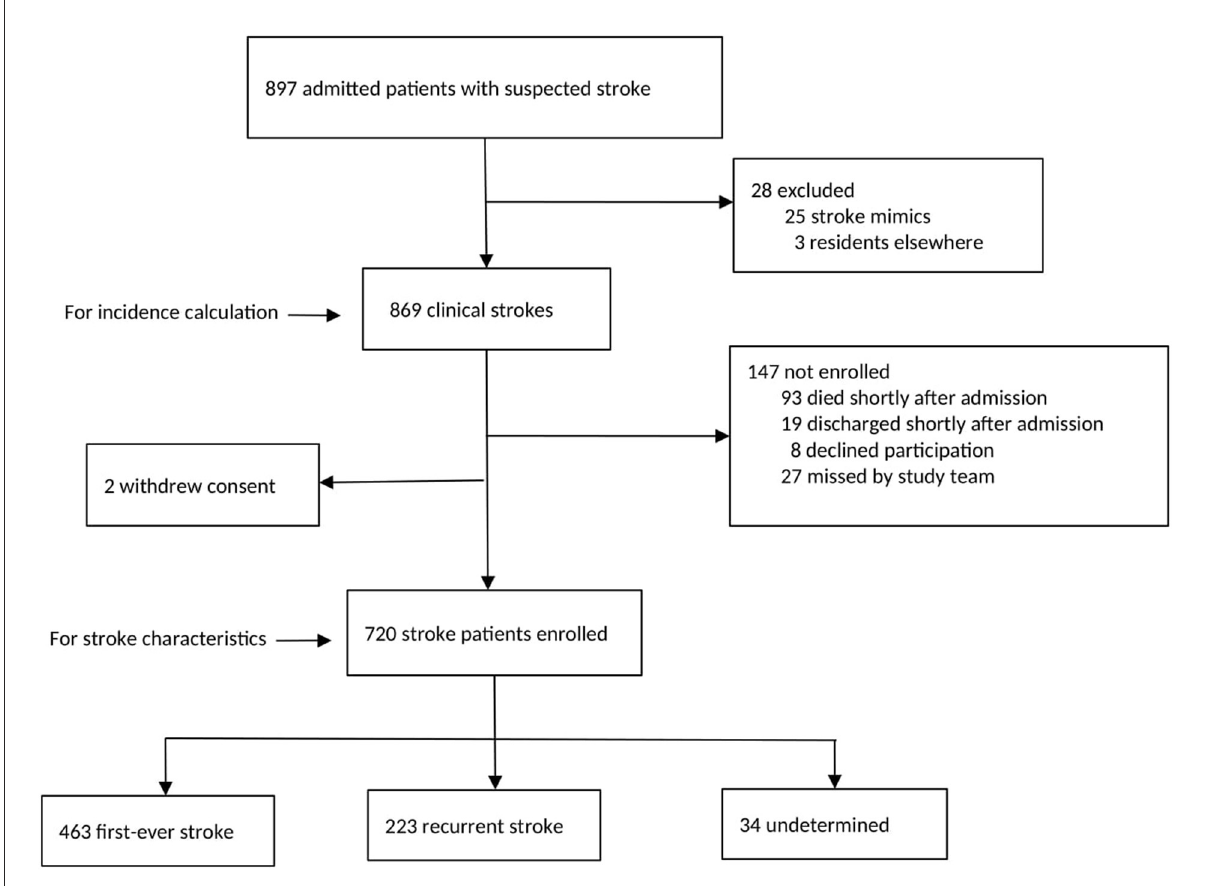
FIGURE1 Analytic samples for incidence calculation and participant